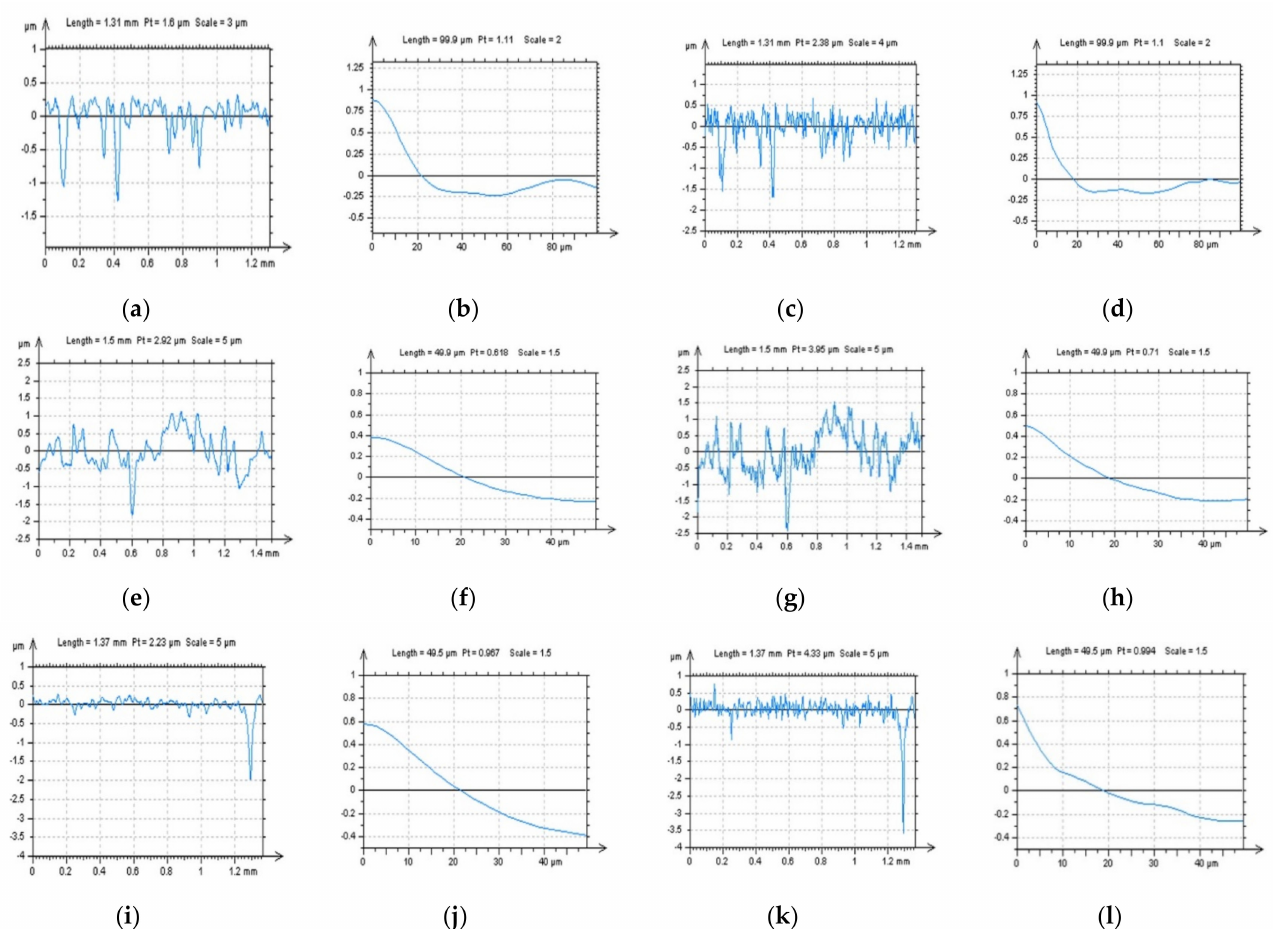
Figure 10. Plateau ( a – d ), valley ( e – h ) and treatment-trace ( i – l ) profiles with their ACFsextracted from a plateau-honed cylinder liner surface presented in Figure 9, received from raw measured data ( a , b , e , f , i , j ) and data with modelled (added) high-frequency errors ( c , d , g,h , k , l